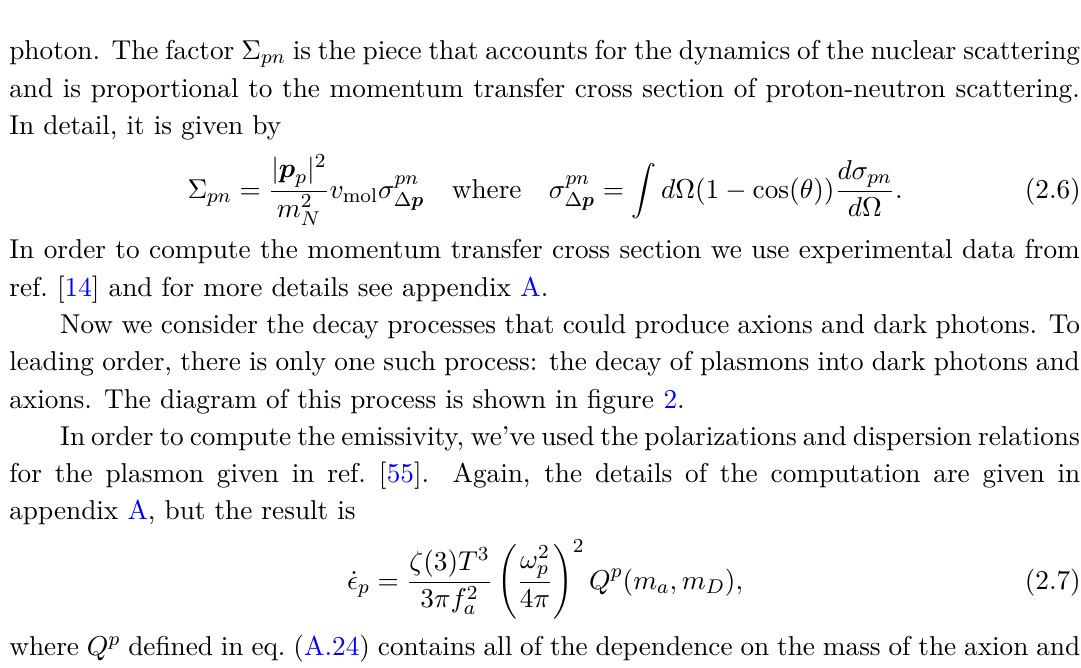
Figure 2 . The leading order decay process that can produce a dark photon and axion. A plasmon γ p decays into an axion and a dark